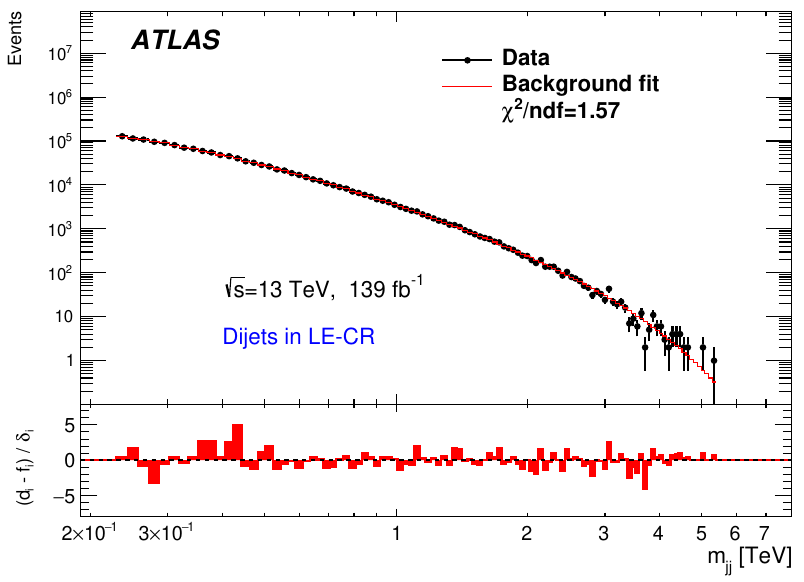
Figure 6. Dijet invariant-mass distribution for the LE-CR region for the 2015{2018 data. Also shown is the result of the (cid:12)t with the (cid:12)ve-parameter background function. The lower panel shows the (cid:12)t residuals divided by the uncertainty on data points. No systematic uncertainties are